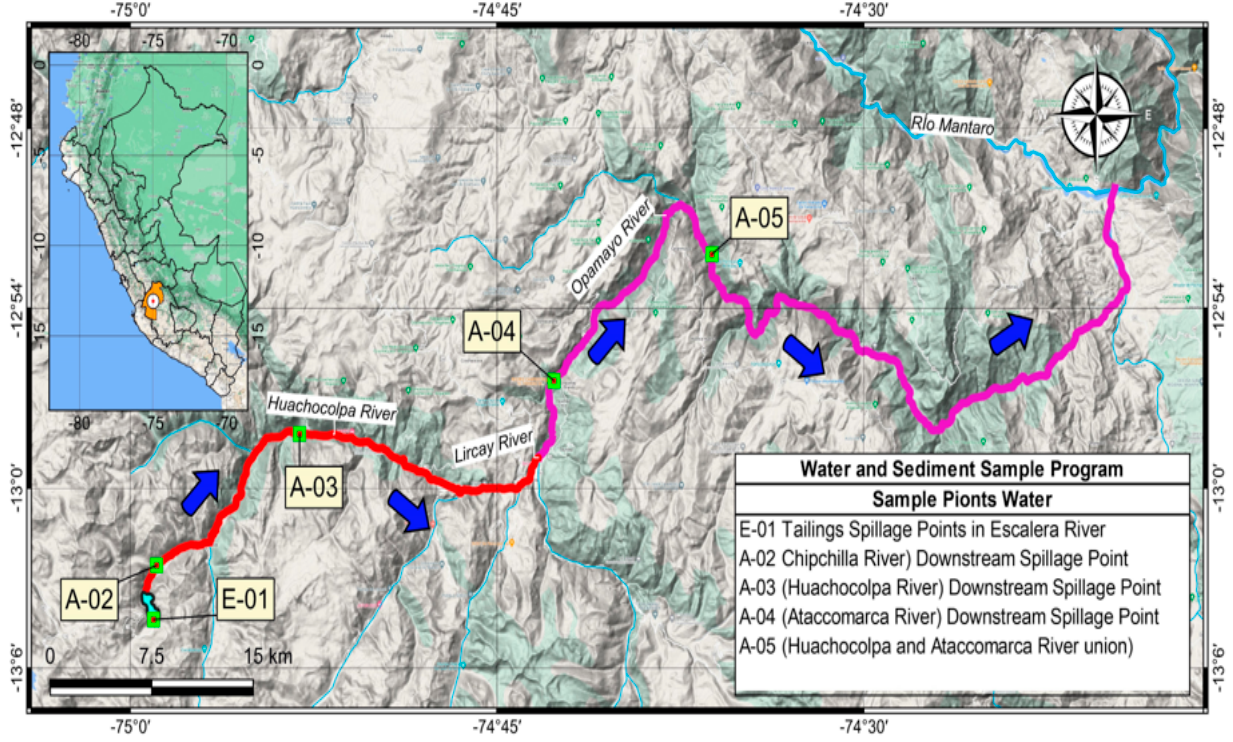
Figure 6. Water Monitoring Points in Tailings Spills—Huancavelica Department (Modified from